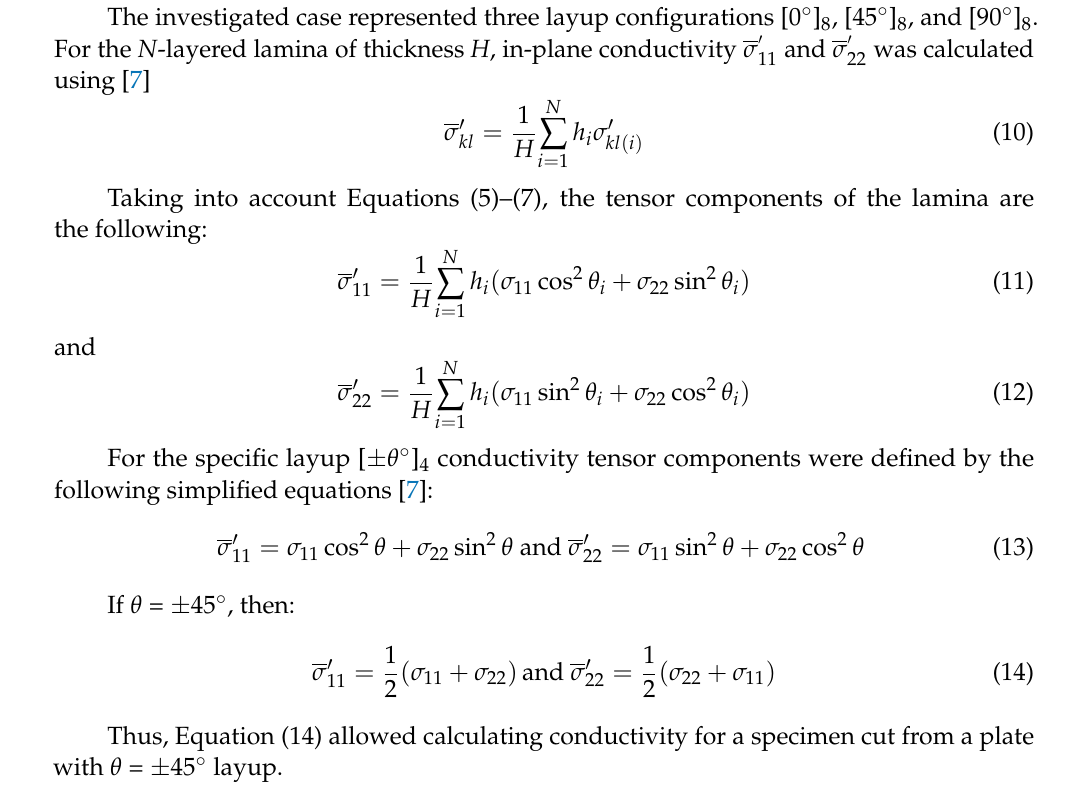
Figure 6. Lamination scheme: ( a ) Stacking of monolayers with angles 0, 90, and ± θ ◦ ; ( b ) fully stacked